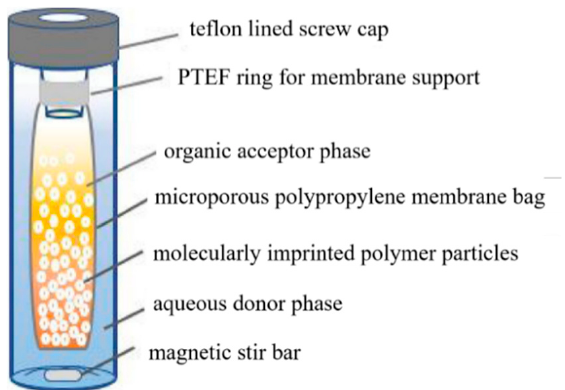
Figure 12. Experimental set-up of the MASE-MIP technique for the analysis of PAHs in wastewater. Reproduced with permission from [49].